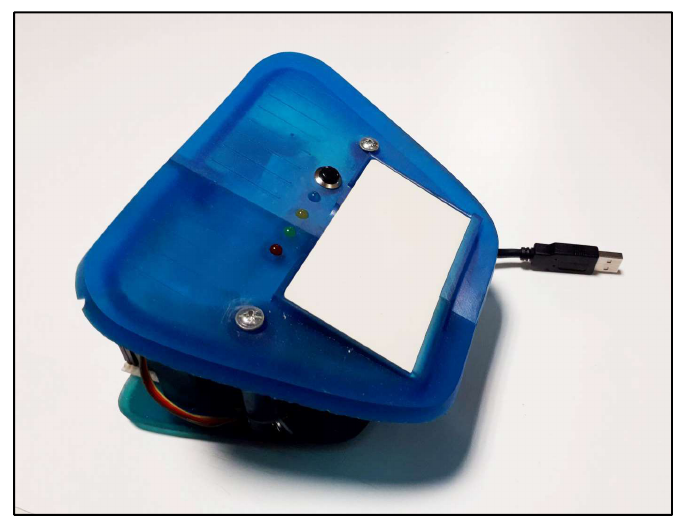
Figure 11. The prototype of the experimental data logger used to test the mobile communication among the EV and the LoRaWAN infrastructure of A2A Smart City. The data logger recovers the telemetry data from the OBD device installed on the EV bus and transmits the required information through a LoRa modem. EV: Electric Vehicle, OBD: On-Board Diagnostic.